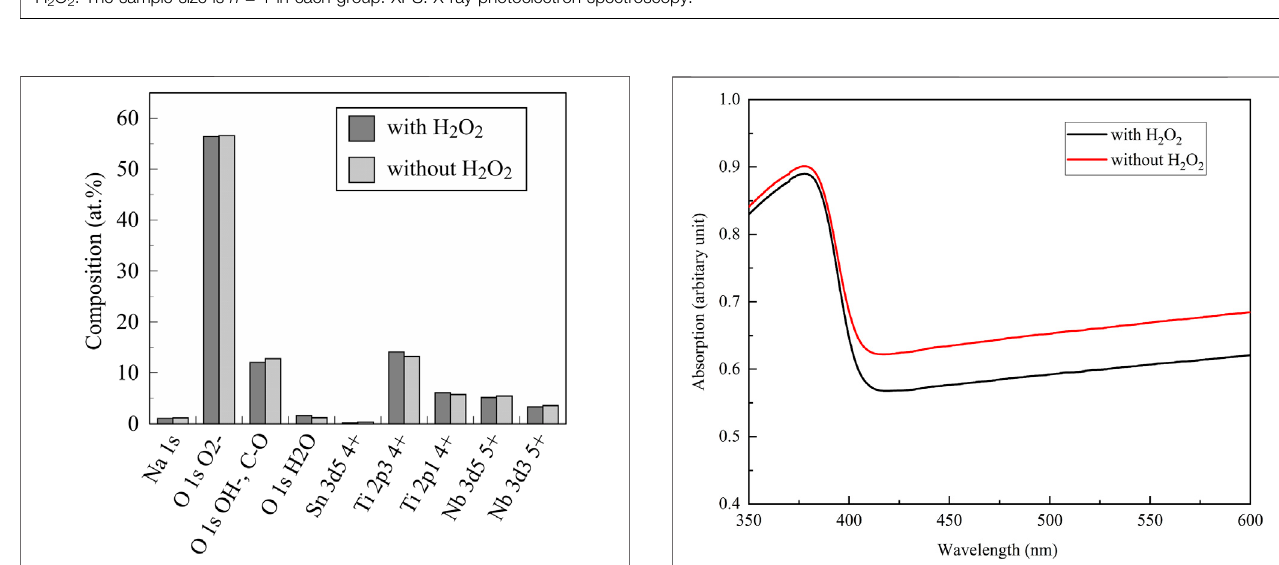
FIGURE 4 | XPS spectra of (A) Ti 2p, (B) Nb, (C) Sn, and (D) O 1s on the anodic oxide with and (E) Ti 2p, (F) Nb, (G) Sn and (H) O 1s on the anodic oxide without H